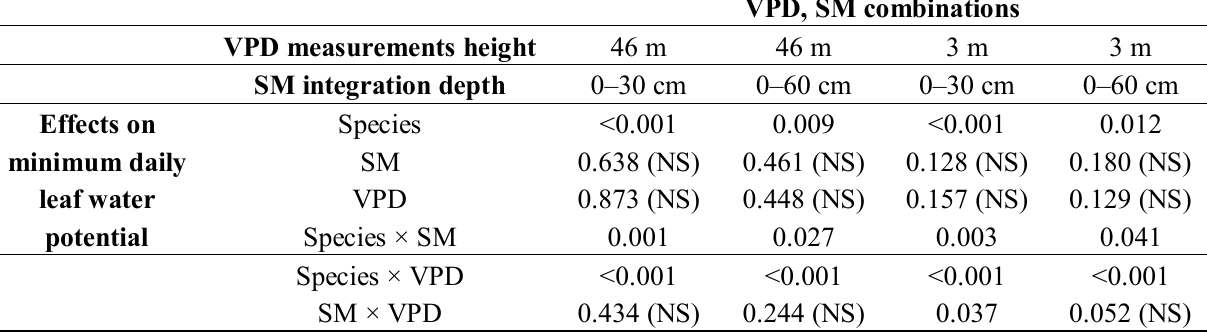
Table 1. The results of mixed linear models testing the significance of different variables and interactions affecting minimal leaf water potential in twelve trees of two species ( Q. rubra and A. rubrum ). Vapor pressure deficit (VPD), soil moisture (SM) and species were included as effective variables. Sample size in each test is n = 67. Soil moisture was measured over two depth intervals: 0–30 cm and 0–60 cm. VPD was measured at two heights: at 46 m above ground (above canopy) and at 3 m above ground (sub-canopy). For both soil moisture and VPD, data at different levels where highly correlated. Four models were run using pair-wise combinations of the two depths and heights. The p-values for each output are listed. Statistical significance was assumed at p < 0.05. (NS) means not significant. The product sign denotes the interaction term of the variables tested for in the mixed linear model.